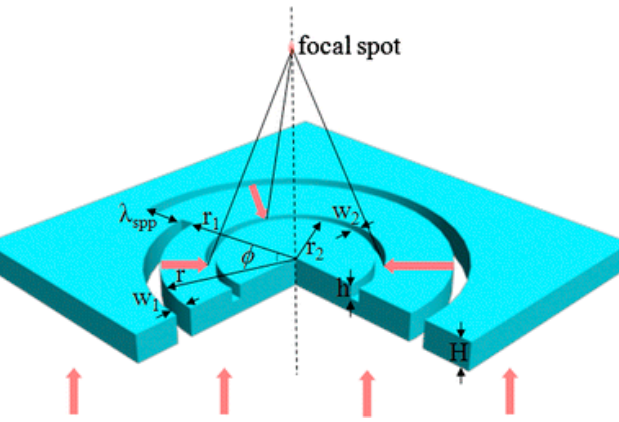
Figure 8. Schematic diagram of the designed structure under the illumination of the RCP plane wave along the positive z -direction. Reproduced with permission from [48]. Copyright Springer, 2011.